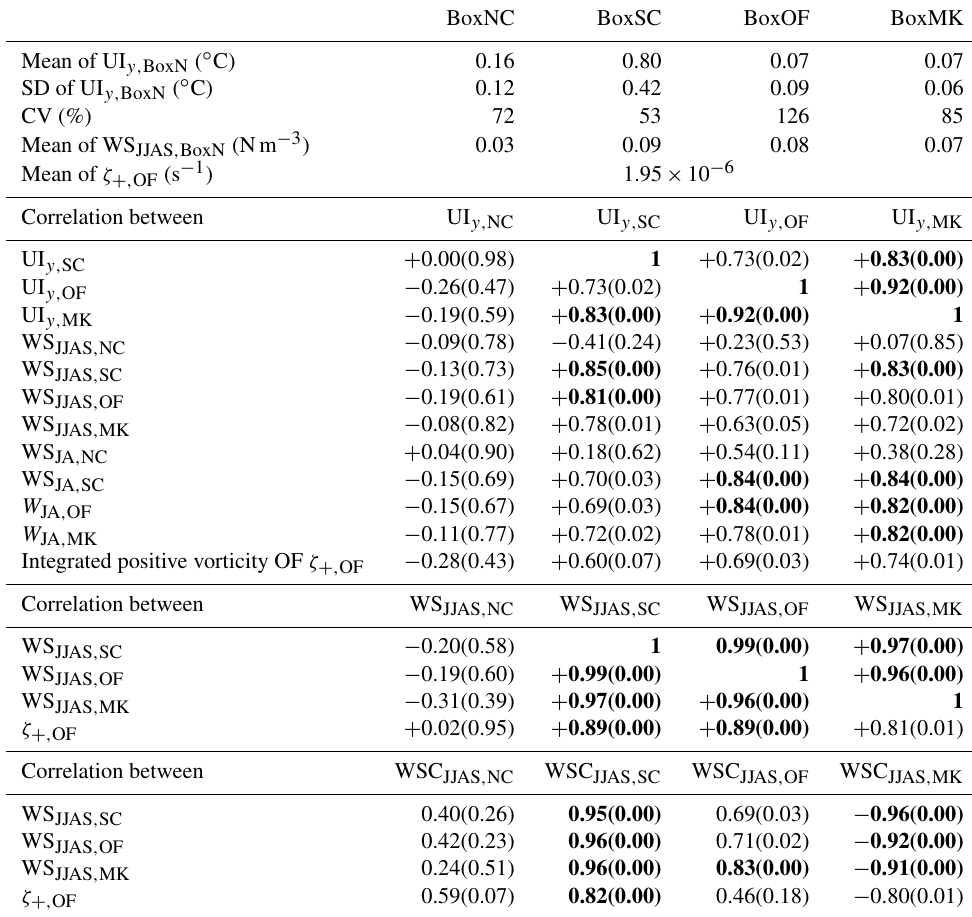
Table 2. From first to last row: temporal mean and standard deviation of UI y , BoxN over 2009–2018 for each box and coefficient of variation (CV) defined as the ratio between the standard deviation (second row) and mean (first row); mean of JJAS (June–September) average wind stress over each box; mean of integrated positive vorticity over BoxOF; correlations (correlation coefficient and associated p values) between time series of significant factors: yearly upwelling index over each box vs. yearly upwelling index over other boxes vs. JJAS and JA (July– August) average wind stress averaged over each box vs. integrated positive vorticity over BoxOF; average JJAS wind stress over each box vs. average JJAS wind stress over other boxes and vs. integrated positive vorticity over BoxOF; average JJAS wind stress curl (WSC) over each box vs. average JJAS wind stress over other boxes and vs. integrated positive vorticity over BoxOF. Correlations significant at more than 95% ( p< 0 . 01) are highlighted in